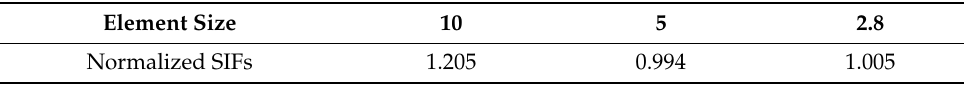
Table 1. Normalized SIFs in the central cracked plate.